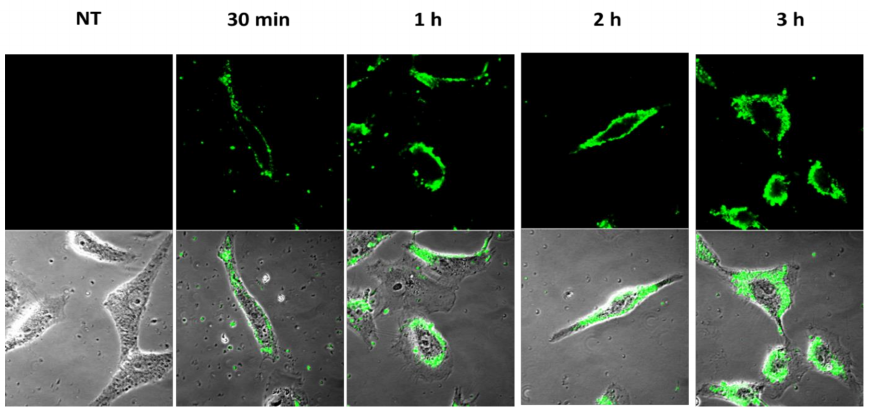
Figure 7. Cell uptake of fluorescent NS. Vero cells were incubated with the formulation for the times indicated and then analyzed by confocal laser scanning microscopy without fixation. The upper panels show the fluorescence images while the lower panels show fluorescence images merged with phase-contrast images. The first column on the left shows the control cells, which were not incubated with the formulation (NT = no